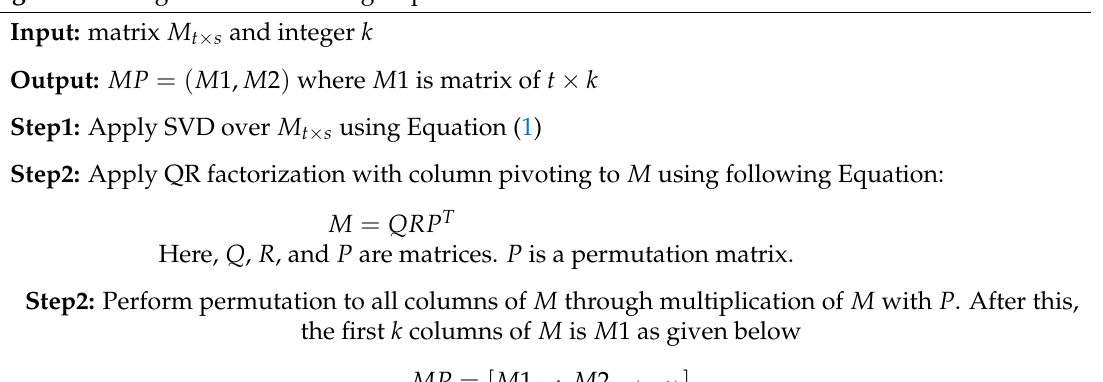
Algorithm 1 Algorithm for Finding Important